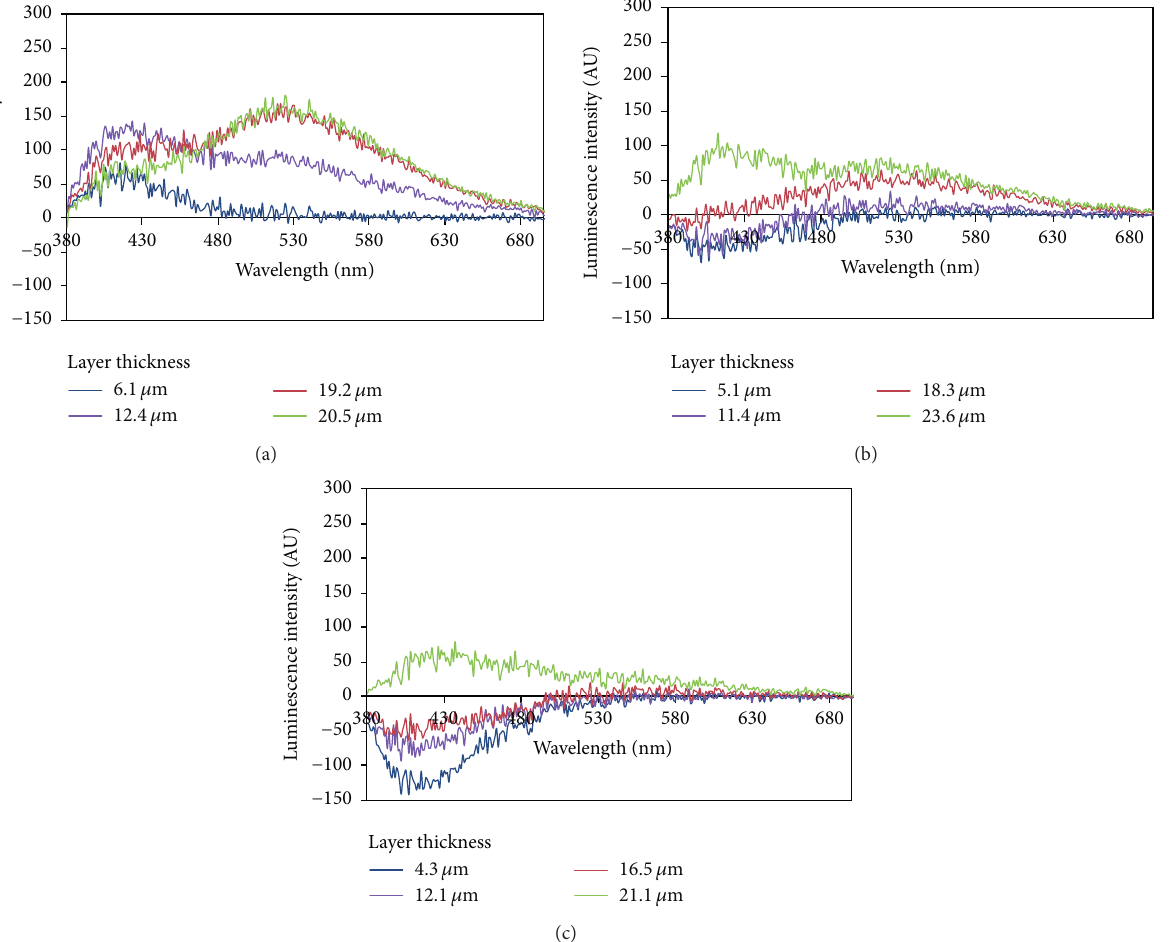
Figure 8: The own luminescence spectra of images printed onto the paper with the medium content of OBAs (paper 2) using the ink compositions with the following contents of the fluorescent component (ZnO nanoparticles): (a) 0.15%; (b) 0.1%; (c)